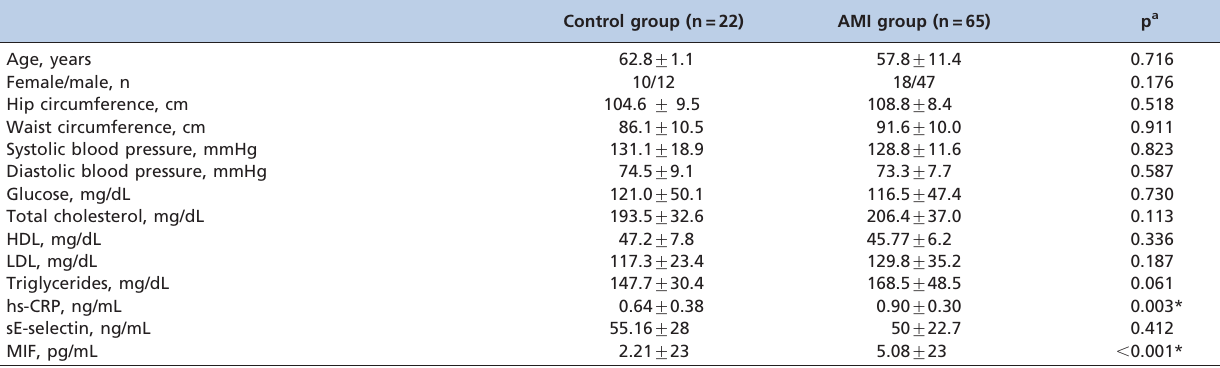
Table 1 - Demographic and biochemical characteristics of the patients in the AMI and control